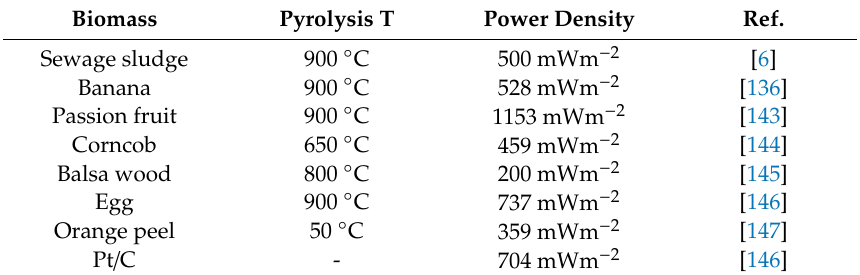
Table 3. Summary of the MFC performance (power density) of biochar catalysts obtained by di ff erent sources of biomass, and di ff erent pyrolysis treatments. Biomass Pyrolysis T Power Density Ref. Sewage